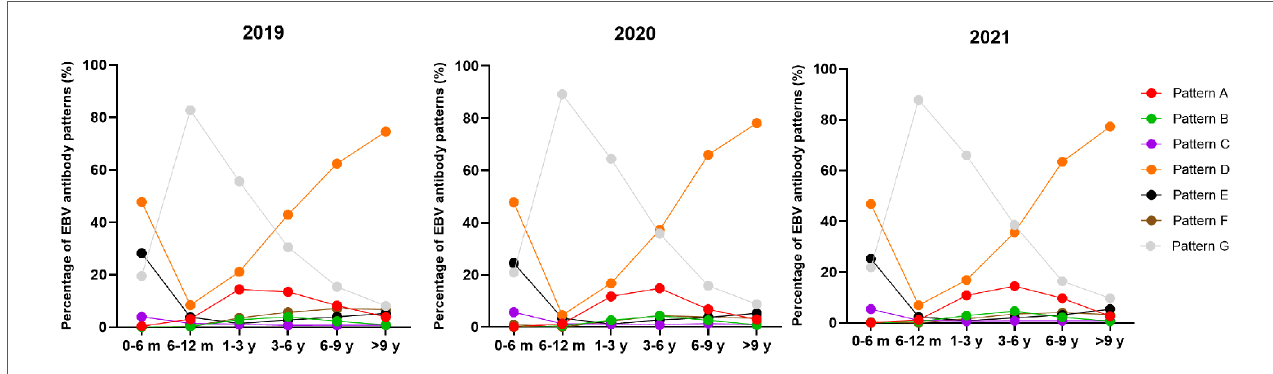
FIGURE 1 The percentage of EBV antibody patterns based on age between January 2019 and December